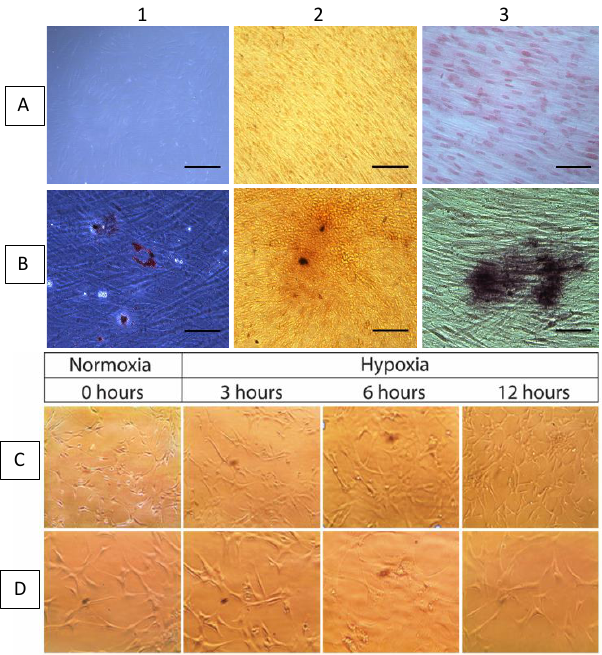
Figure 3. ( A1 – A3 ) Undifferentiated GMSCs control for each lineage; ( B1 ) adipogenic, ( B2 ) osteogenic, and ( B3 ) chondrogenic differentiation of GMSCs; ( C , D ) GMSCs under hypoxic environment (baseline, 3, 6 and 12 h) maintained their fibroblast-like, spindle shape and plastic-adherent properties, reaching a slightly higher confluence ( D ) versus normoxic controls ( C ). Scale bar: 50 μm.